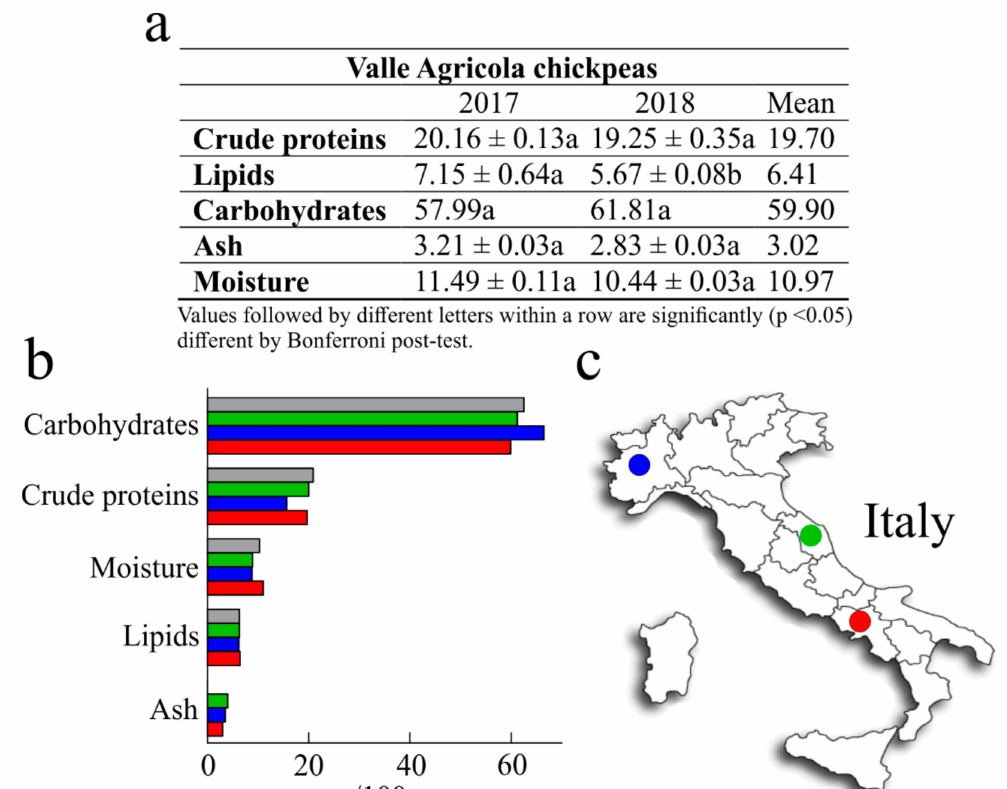
Figure 2. ( a ), nutritional values of Valle Agricola chickpeas collected in the years 2017 and 2018. Values are means ( ± SD) of triplicate analyses ( n = 3) and are expressed on dry-weight basis (g/100 g). ( b ), average values of Valle Agricola chickpeas seeds ( (cid:4) ) compared with those of common Italian chickpeas reported by the Centro di Ricerca per gli Alimenti e la Nutrizione ( (cid:4) ), and with Merella ( (cid:4) ) and Alta Valle di Misa ( (cid:4) ) Italian chickpeas grown in Piemont and Marche regions. ( c ), geographic localization of Merella ( ) and Alta Valle di Misa ( ) chickpeas, grown in Piedmonte and in Marche, two northern and (cid:32) (cid:32) central Italian regions, respectively, while in red ( ) geographical position of Valle Agricola town (Southern (cid:32)